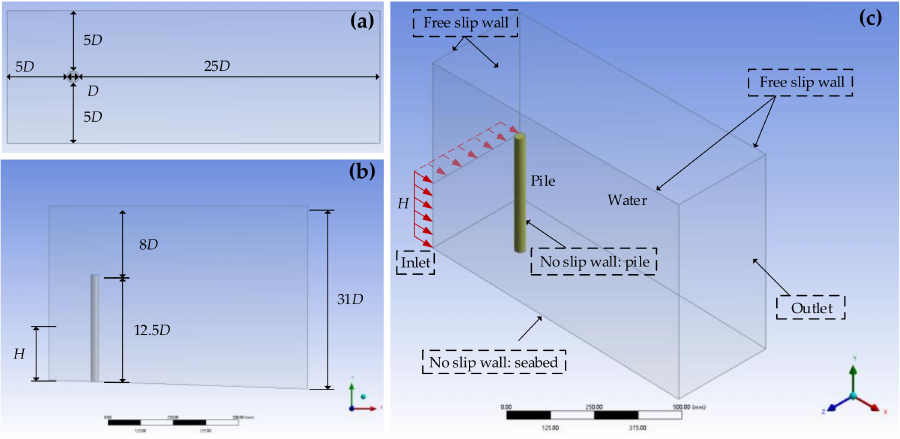
Figure 2. Geometric model and boundary settings. ( a ) Top view; ( b ) side view; ( c ) aerial